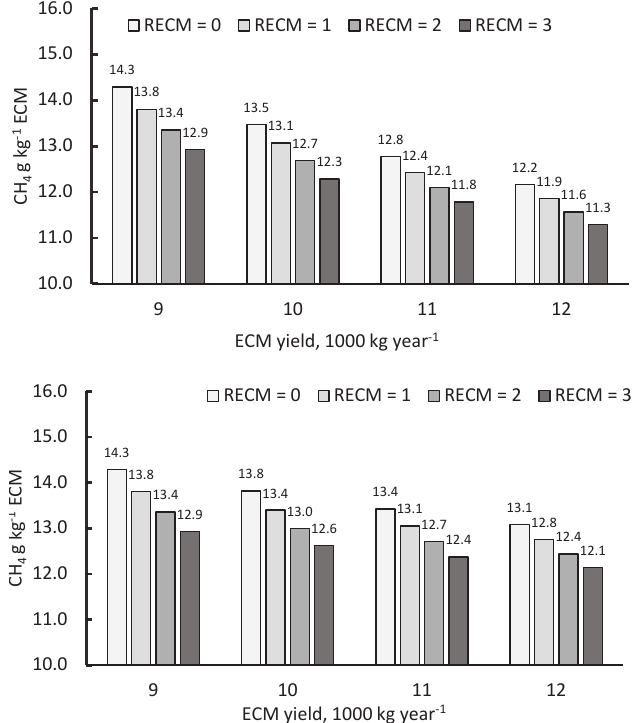
Fig. 7. The effects of increased ECM yield and reduced residual feed intake (RFI) methane intensity (kg CH kg -1 ECM) when ECM yield increased without (above) 4 with (below) associated changes in BW (30 kg per 1000 kg